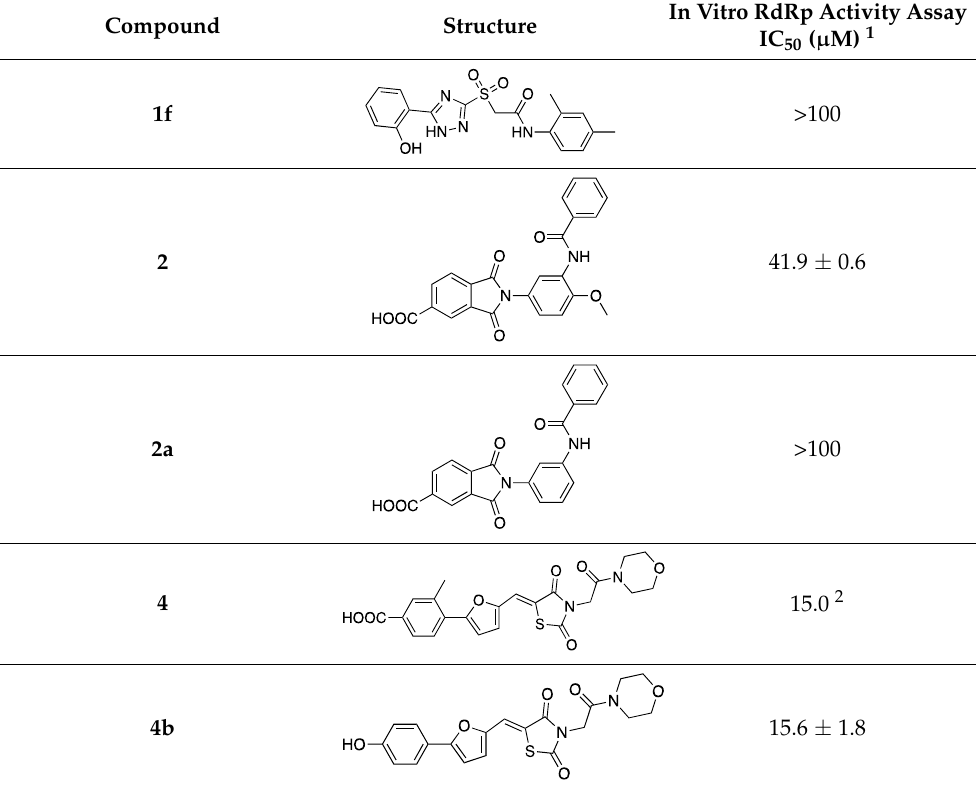
Table 1. IC 50 values and structures of the novel compounds against HuNoV (GII.4) RdRp activities.